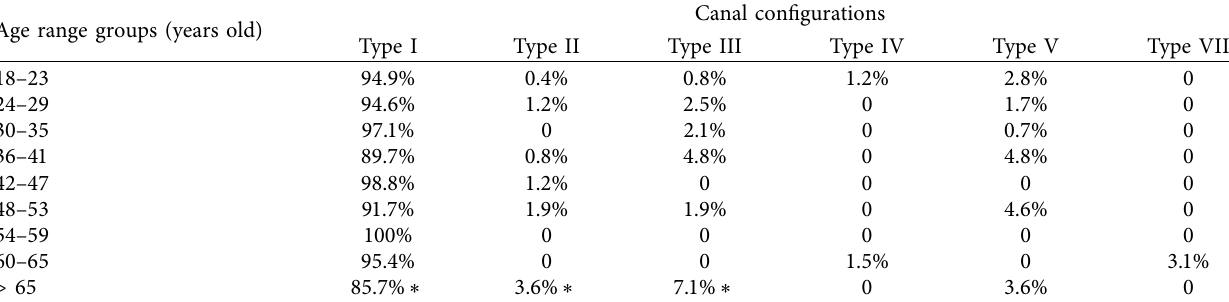
∗ Significant at P ≤ 0 . 05. Table 5: Prevalence of different types of canal configurations among different age groups. Age range groups (years